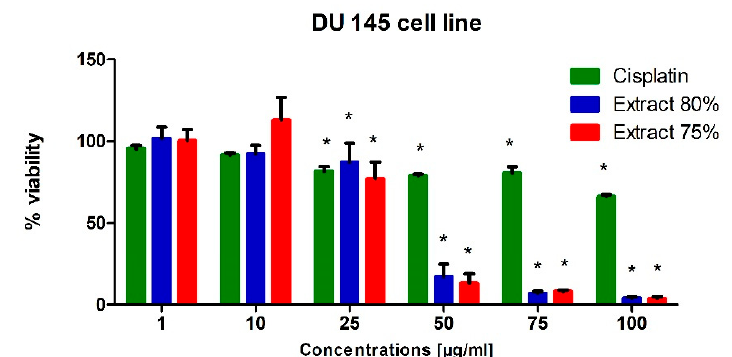
Figure 2. Viability of the DU-145 cell line (%) after 24 h of incubation with various concentrations of extract at 80%, extract at 75% and Cisplatin used as reference compound, measured with MTT test; Significant values (*) compared with Cisplatin with p < 0.05 (one-way ANOVA with Tukey’s post hoc test).